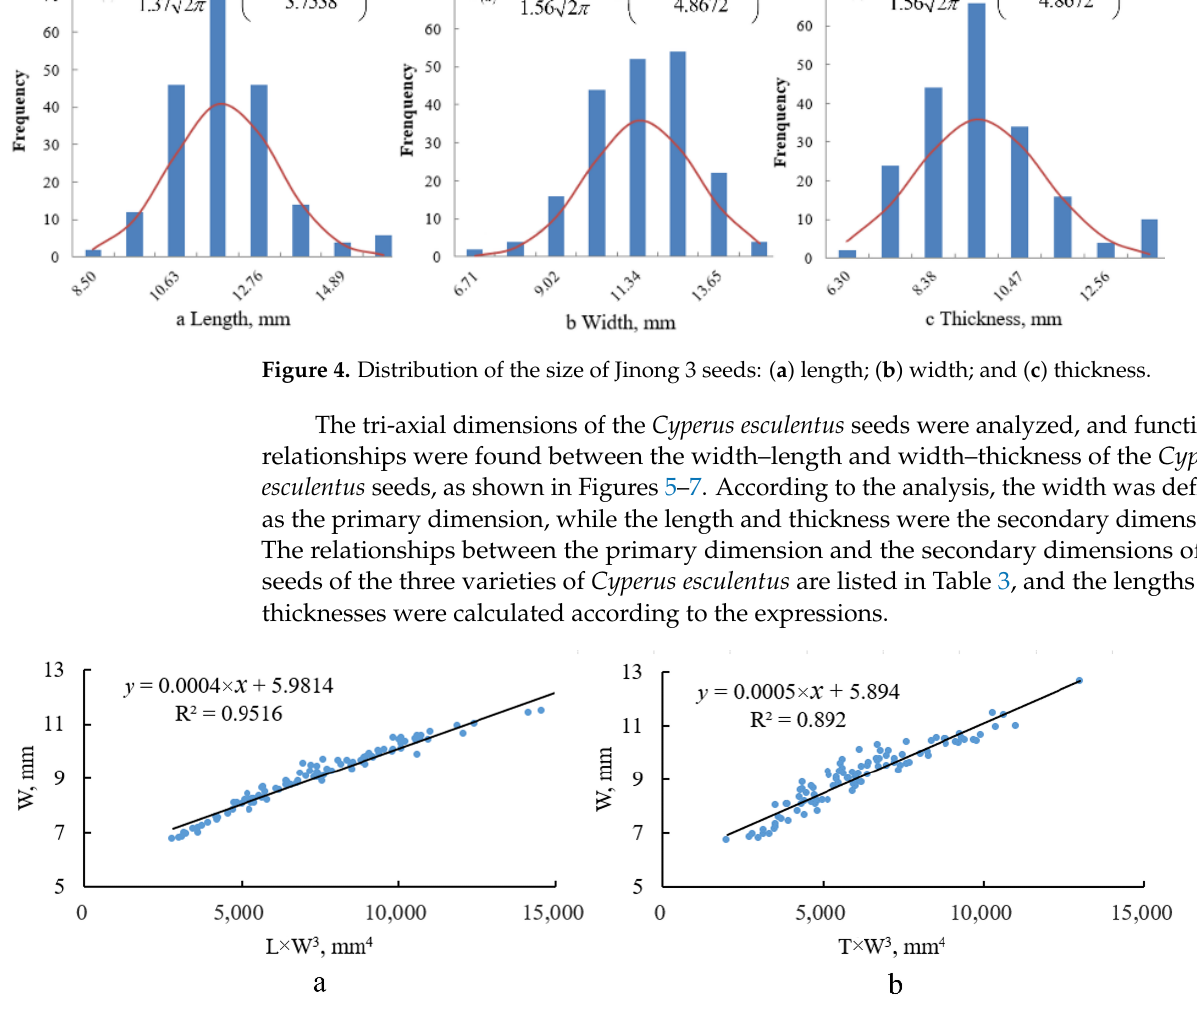
Figure 5. Relationships between two dimensions of Jinong 1 seeds: ( a ) width–length and ( b )